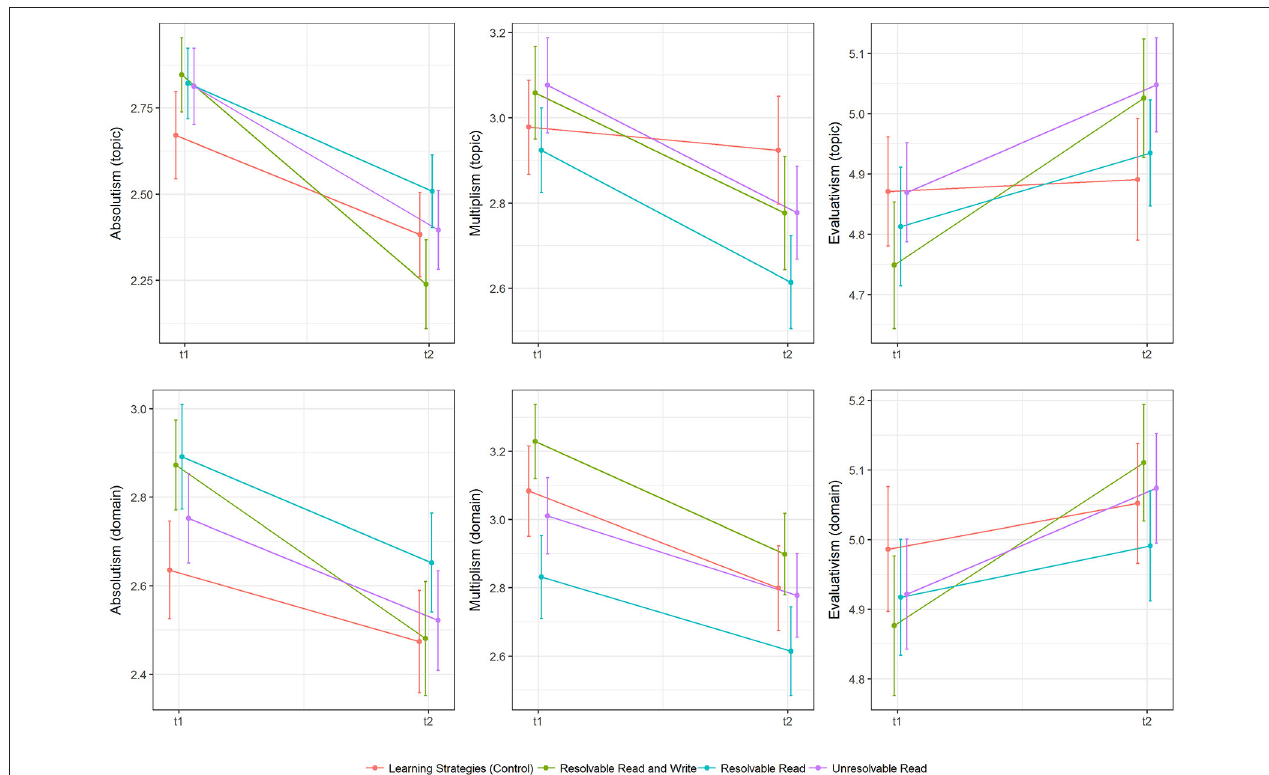
FIGURE 4 | Descriptive differences (means and standard errors) in epistemic change in topic-specific (FREE-GST) and domain-specific (FREE-EDPSY) epistemic beliefs for absolutism, multiplism and